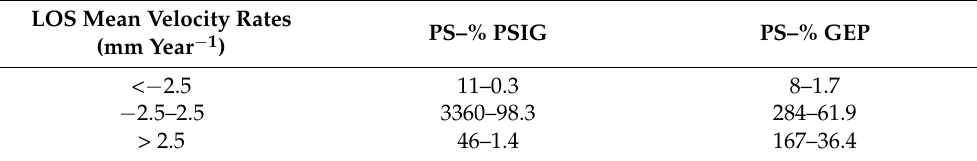
Table 4. LOS mean deformation velocity rates (mm year − 1 ), number of PS with their percentages. LOS Mean Velocity